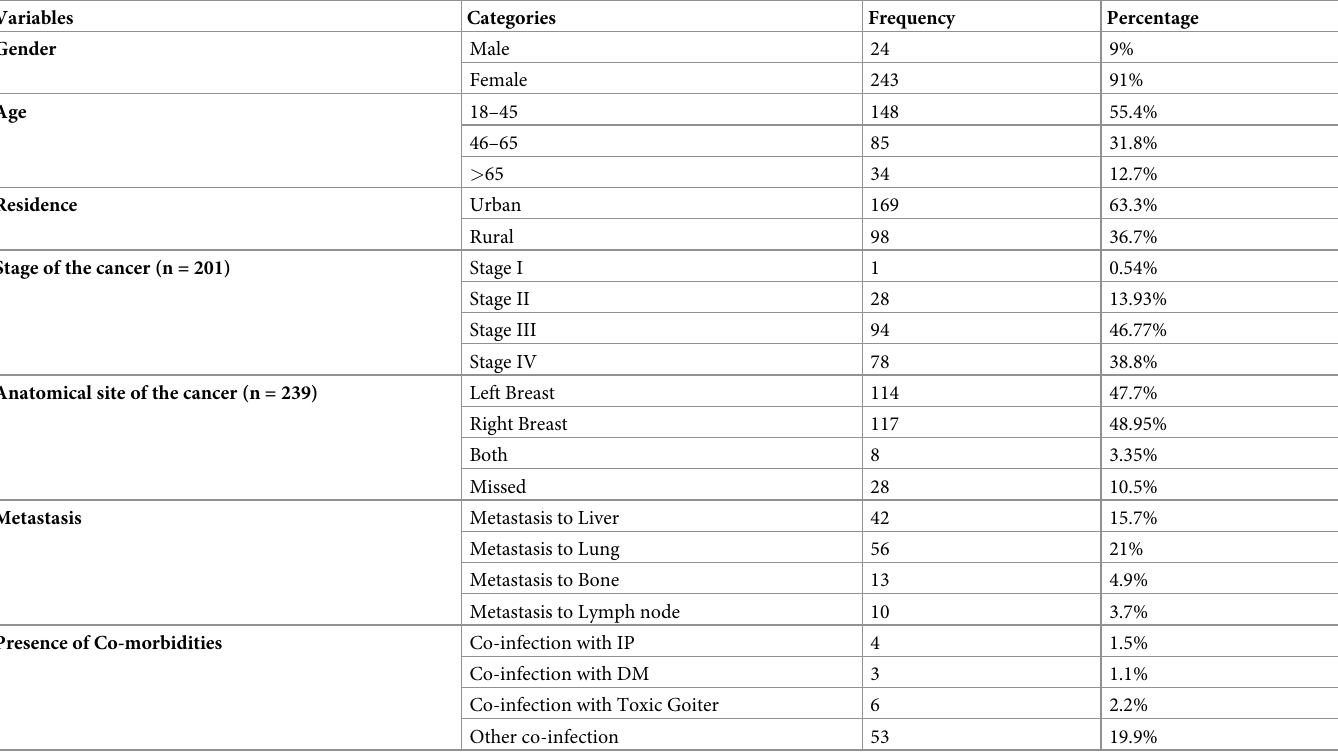
Table 1. Socio demographic and clinical characteristics of breast cancer patients at UoG-CSH, Northwest Ethiopia,